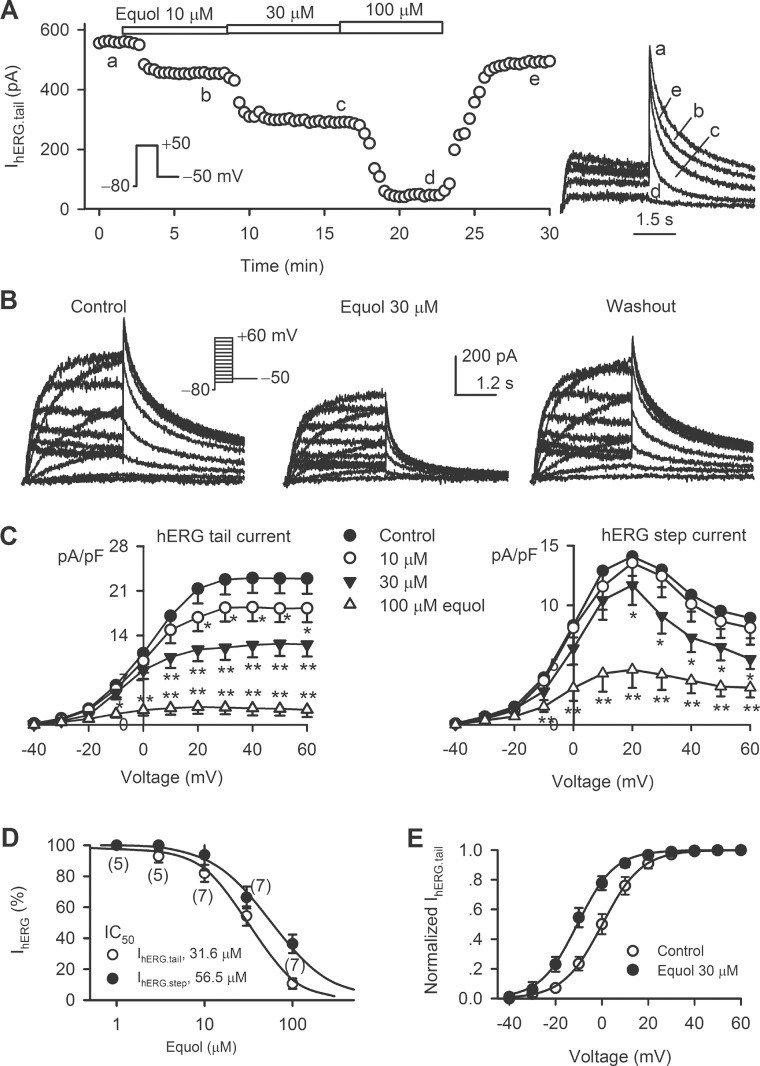
Effects of equol on hERG channels.(A) Time course of IhERG.tail recorded in a representative HEK 293 cell stably expressing KCNH2 with the voltage protocol shown in the inset in the absence and presence of 10, 30, and 100 μM equol. Original current traces at corresponding time points are shown in the right. (B) Voltage-dependent IhERG traces recorded in a typical experiment in the absence and presence of 30 μM equol and upon washout. (C) I-V relationships of IhERG.tail (left) and IhERG.step (right) in the absence and presence of 10, 30, and 100 μM equol (n = 7, *P<0.05, **P<0.01 vs. control). (D) Concentration-response relationships of equol for inhibiting IhERG.tail and IhERG.step were fitted to the Hill equation. The numbers in the parentheses represent experimental number. (E) Variables of normalized IhERG.tail in the absence and presence of 30 μM equol were fitted to the Boltzmann equation.